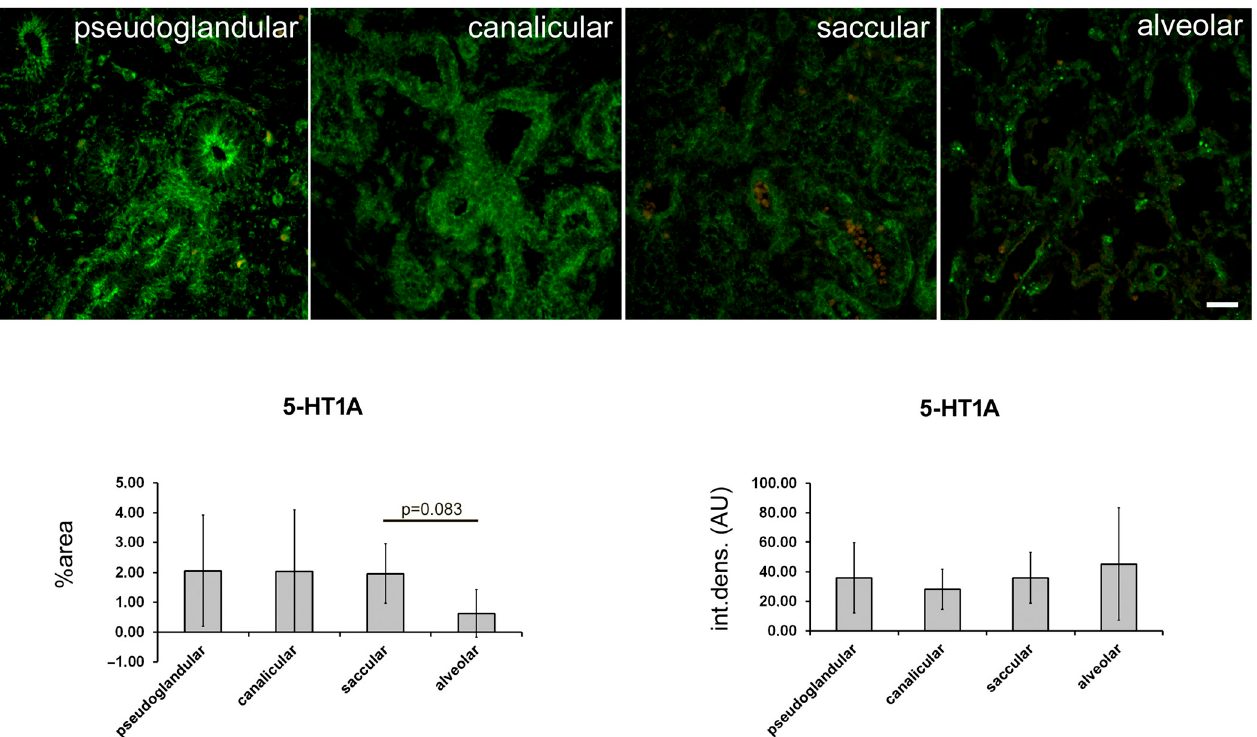
Figure 3. Quantification of 5-HT1A expression at different stages of fetal lung development. Immunofluorescence staining with 5-HT1A antibodies was performed. Representative images for different stages of lung development are shown. Green fluorescent staining—positive 5-HT1A receptor expression. Images were acquired at 400× magnification. Scale bar = 50 µm. The percentage of a sectional area with positive signal (% area) and the integrated density (int. dens.; arbitrary fluorescence units—AU) were measured and are presented in graphs.